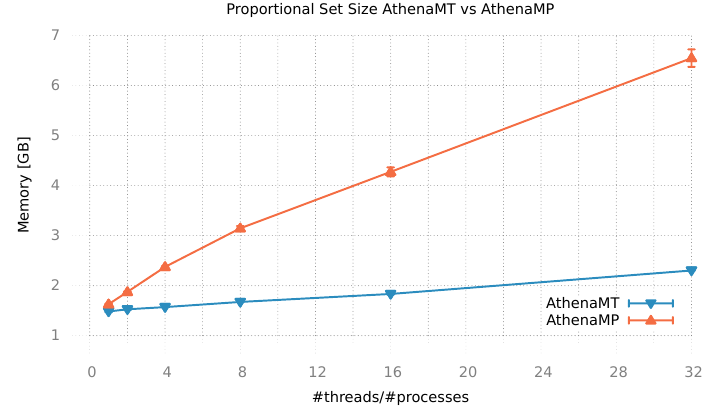
Figure 6: Memory Occupancy (Proportional Set Size) of AthenaMT (blue) vs. AthenaMP (orange), as a function of the number of threads or processes, respectively.